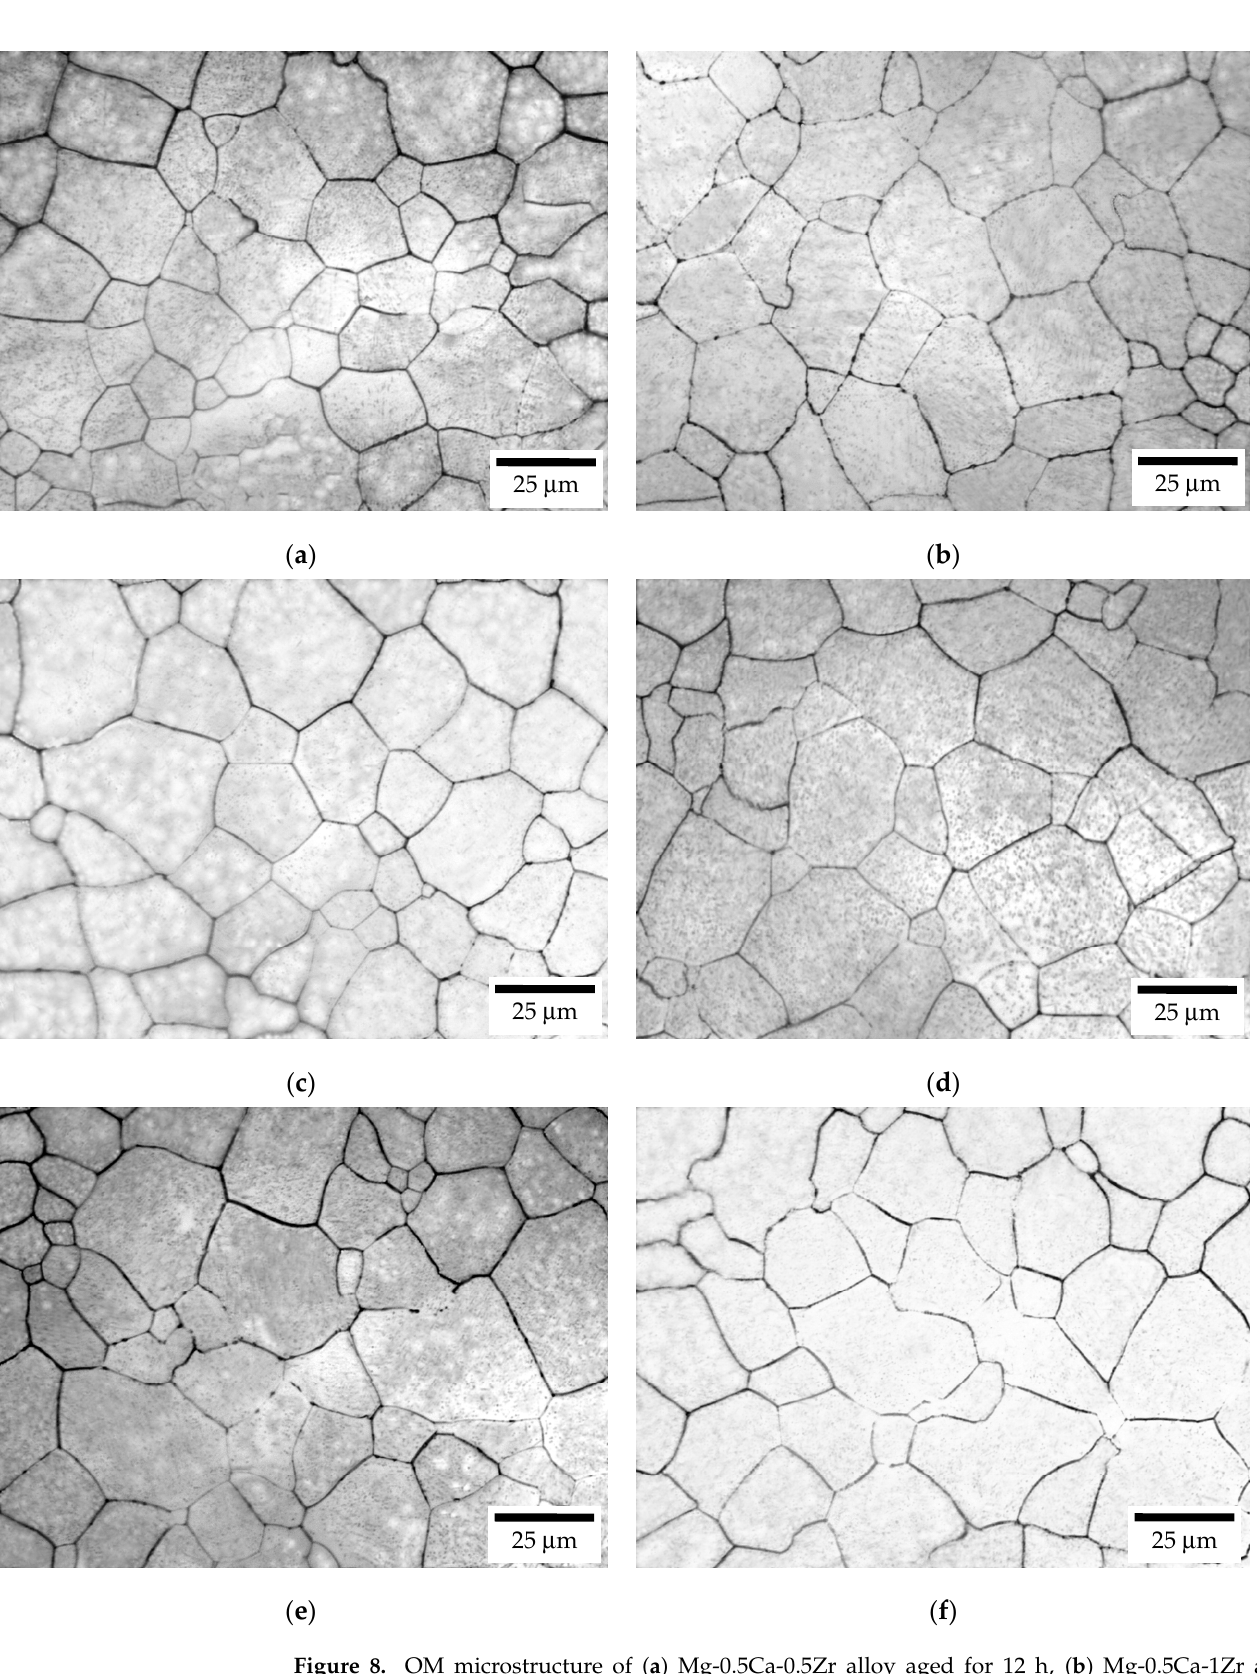
Figure 8. OM microstructure of ( a ) Mg-0.5Ca-0.5Zr alloy aged for 12 h, ( b ) Mg-0.5Ca-1Zr alloy aged for 12 h, ( c ) Mg-0.5Ca-0.5Zr alloy aged for 24 h, ( d ) Mg-0.5Ca-1Zr alloy aged for 24 h, ( e ) Mg-0.5Ca-0.5Zr alloy aged for 48 h and ( f ) Mg-0.5Ca-1Zr alloy aged for 48 h.